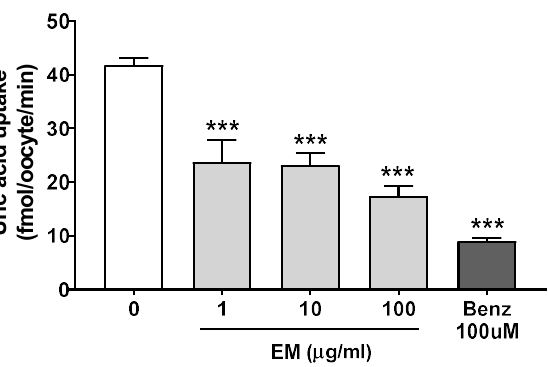
Figure 6. The effect of EM on uric acid uptake in in vitro hURAT1-overexpressing oocytes; ( n = 5 per group). Benz, benzbromarone. *** p < 0.001 vs. the no EM-treated vehicle group.